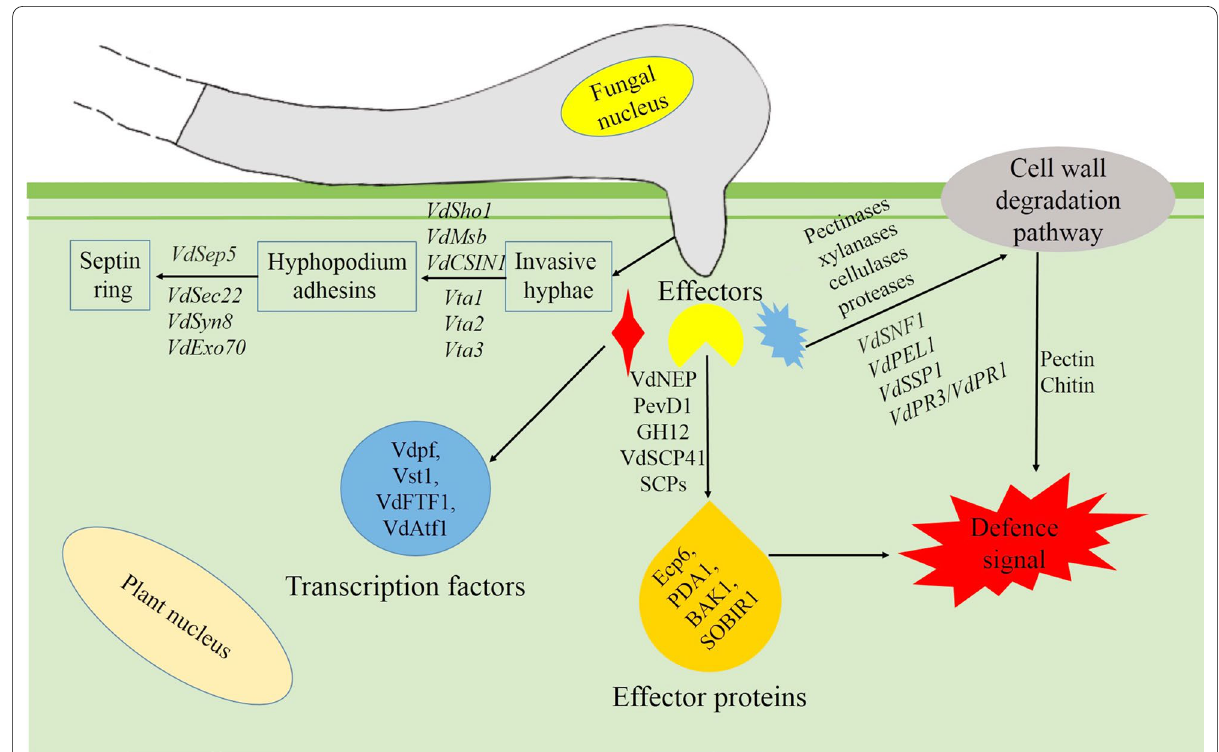
Fig. 2 Regulation of intracellular signalling-related genes in molecular pathogenicity mechanism of Verticillium dahliae in plant. V. dahliae has evolved a sophisticated molecular pathogenicity mechanism to infect plants, a cascade of reaction involving plant cell wall degradation, effector proteins, transcription factors, etc., which will trigger the plant immunity